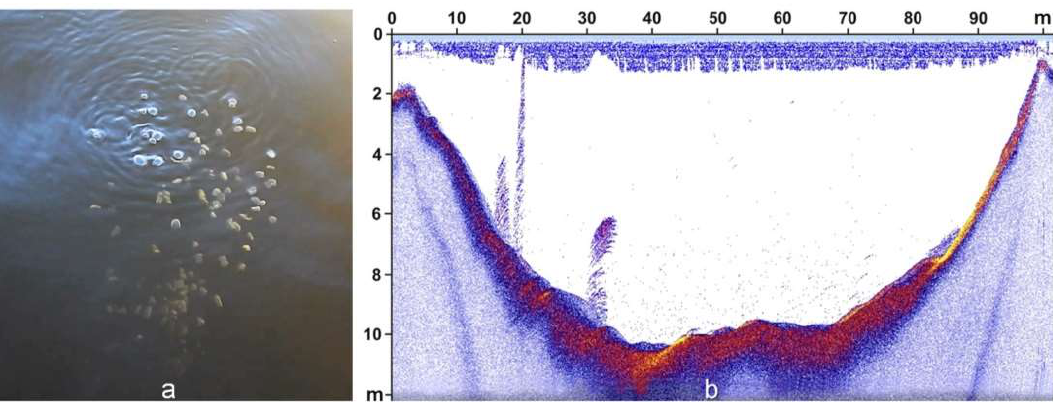
Figure 6. Gas emission (photo by Igor Bogoyavlensky) ( a ) and NW–SE echo sounding section ( b ) with three gas flares on the Seyakha C11 Crater flooded by the river.